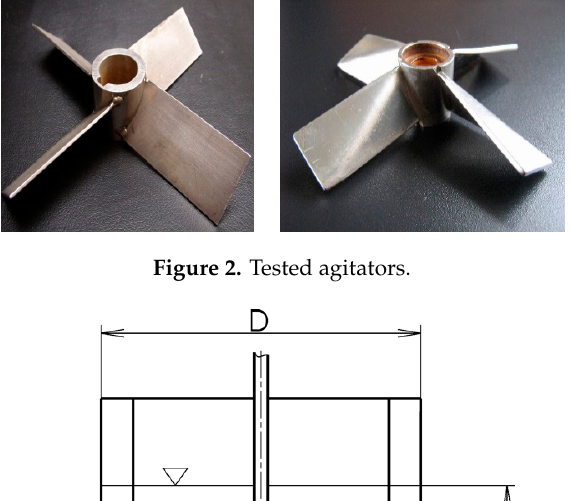
Figure 1. Dependence of Fr´ on relative particle size d p /D and mean volumetric concentration of particles c, presented in [8] (points—experimental results, line—regression according to Equation (2) by least-squares regression analysis).